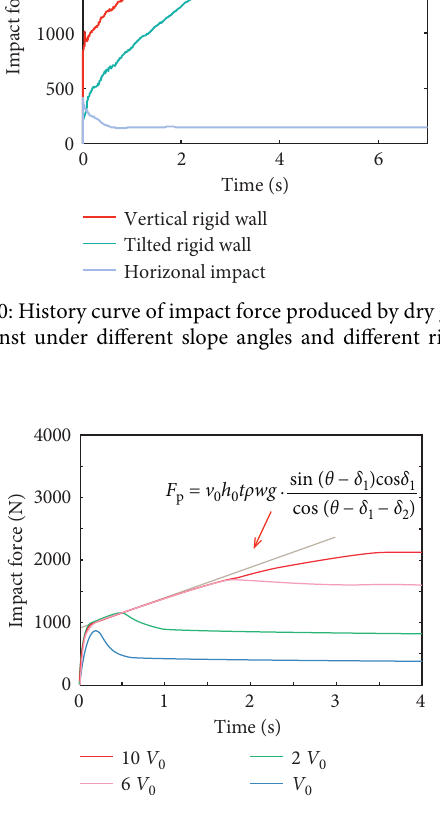
Figure 11: The history curve of dry granular flow with different volume on the rigid